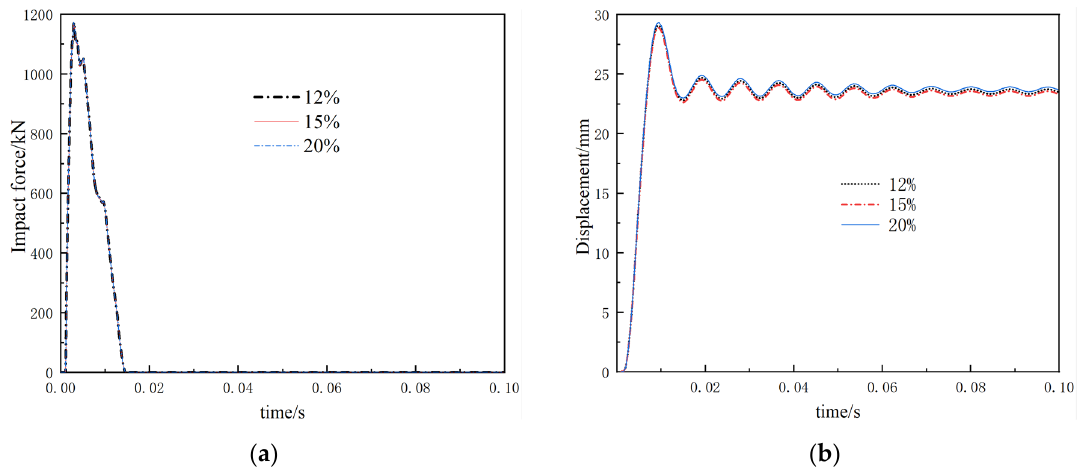
Figure 17. Different expansion rates. ( a ) Impact-time history curve. ( b ) Displacement-time history curve.